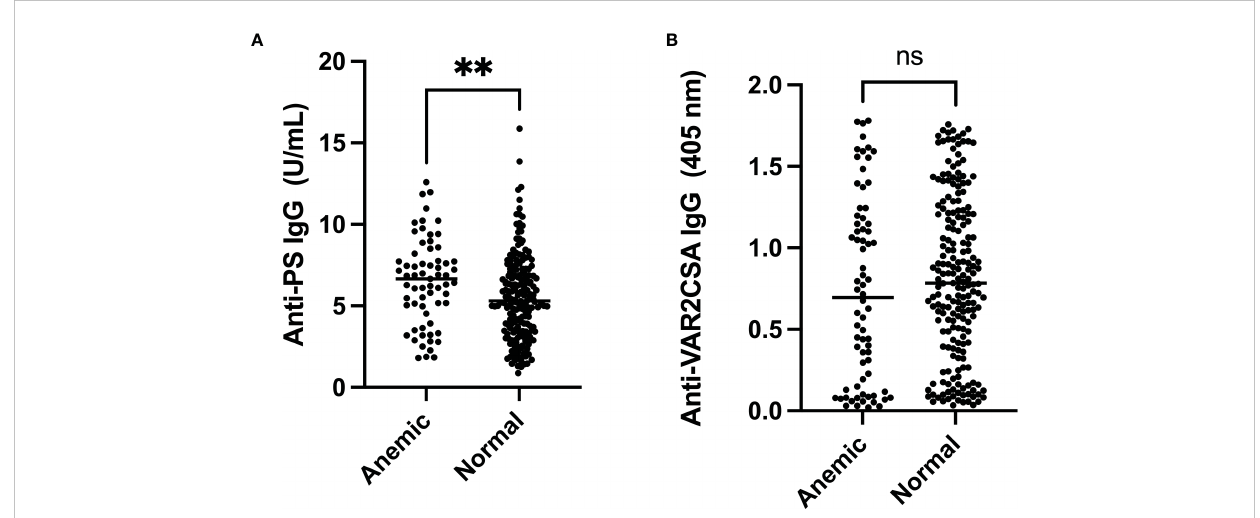
FIGURE 1 Comparison of anti-PS and anti-VAR2CSA antibody levels in pregnant women comparing anemic to those with normal PCV. (A) The median anti-PS antibody level was signi fi cantly higher in anemic pregnant women (** represent ≤ 0.01). (B) There was no difference in median anti-VAR2CSA antibody levels between anemic and normal pregnant women (p = 0.18). ns, not statistically signi fi